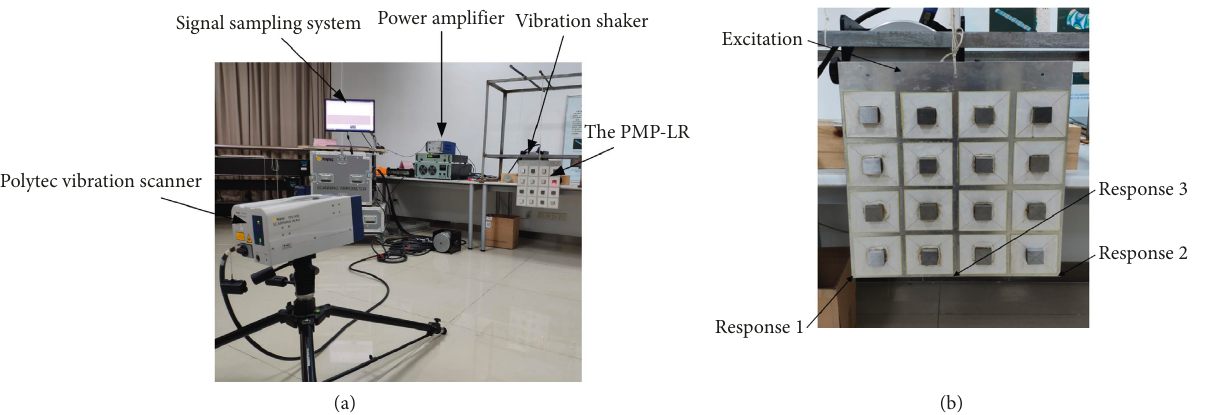
Figure 19: Experimental setup. (a) Whole testing system. (b)